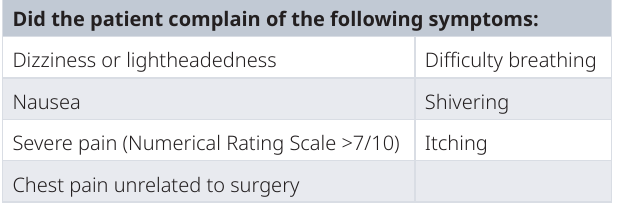
Table 4. Emergency medical interventions.